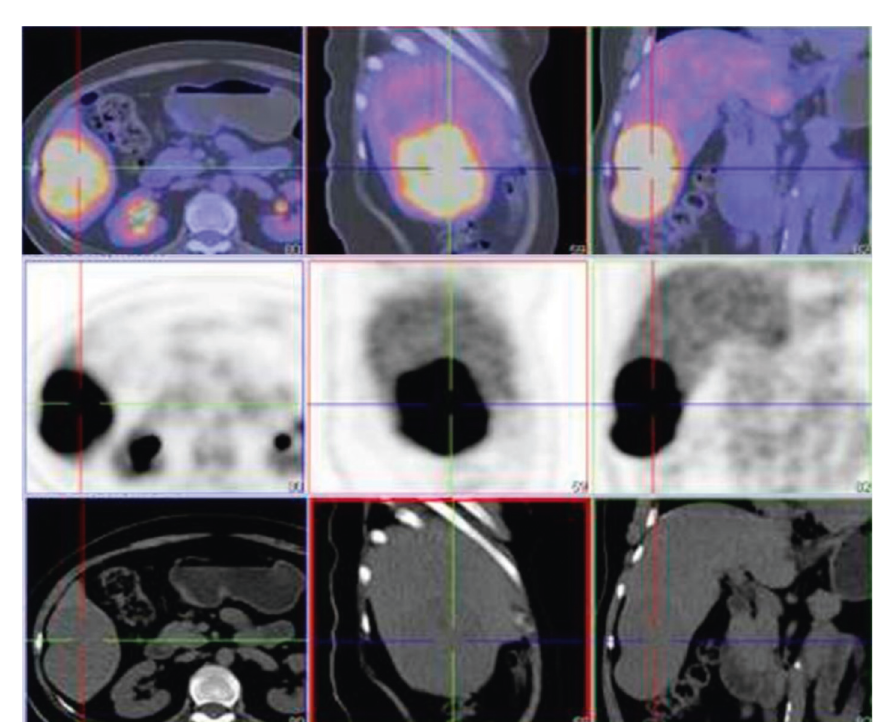
Figure 2: 18 FDG-PET-CTscan of Patient A on 6 July 2016. CTabdomen of Madam F on 9 August 2012. An 8cm liver mass (SUVmax 8.4) was found at segment